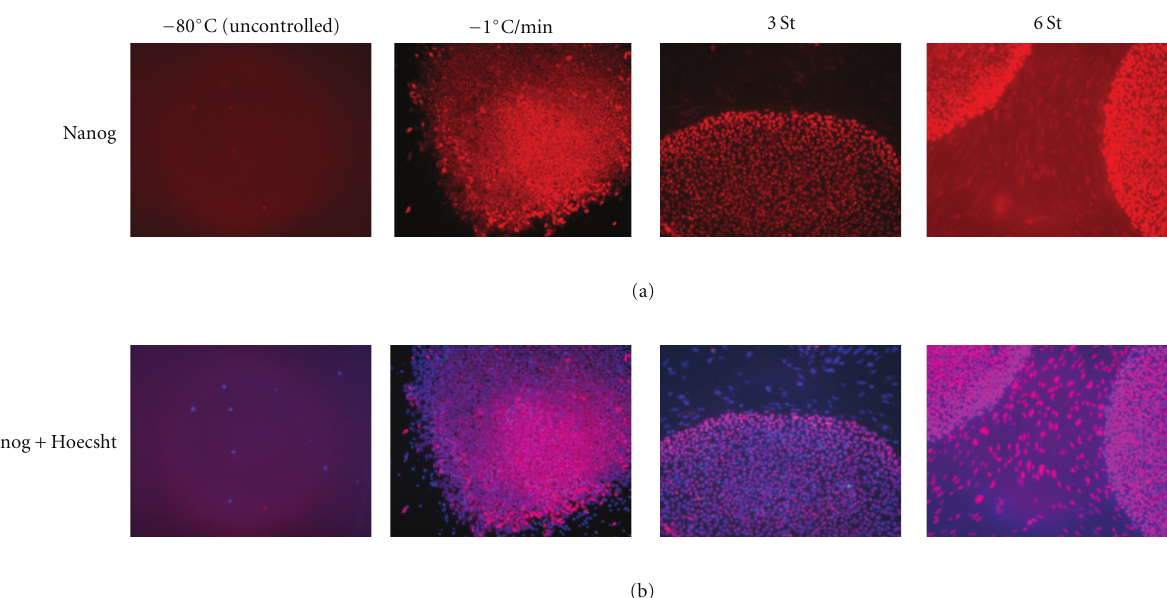
Figure 4: Cryopreservation of aderent human iPSCs in plates. Fluorescent microscopy of human induced pluripotent stem cells frozen in adherent state in 4-well plates. First row: Nanog (immune staining), second row: combined Nanog + Hoechst. The photos were taken on day 3 after thawing. In all cases, ethylene glycol (EG) and ROCK inhibitor Y-27632 were used. − 80 ◦ C: uncontrolled freezing in a –80 ◦ C freezer in a Styrofoam box ( ∼ − 1 ◦ C/min at the first stage of freezing). The yields of viable, and especially Nanog-positive cells, are very low (see Figure 3). − 1 ◦ C/min: one-step freezing in a programmable freezer (Custom Biogenics, Inc, series 2100); Note 1: eroded edges of the colony and di ff erentiation of the adjacent cells within the colony . 3St: three-step freezing protocol (described in Section 3.3) in a programmable freezer. 6St: six-step freezing protocol (described in Section 3.3) in a programmable freezer. Note 2: clear distinct edges of the colonies in BOTH cases and di ff erentiated ( Nanog -negative) cells (blue) outside the colony in the 3-Step protocol. QUANTA has confirmed substantially higher attachment e ffi ciency and a larger 7AAD − /GFP + pool of viable iPSCs in cases of multistep controlled freezing (Figure